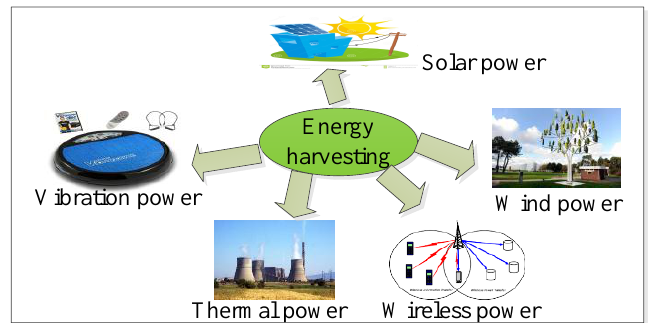
Figure 22. Energy harvesting in IoT.